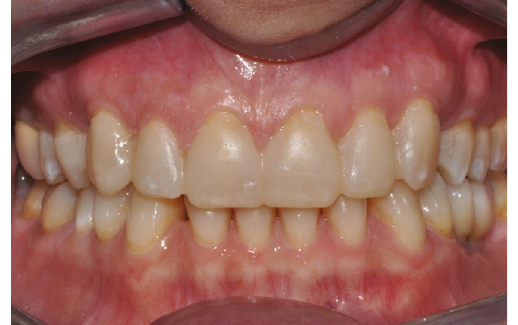
Figure 3: Initial mock-up.